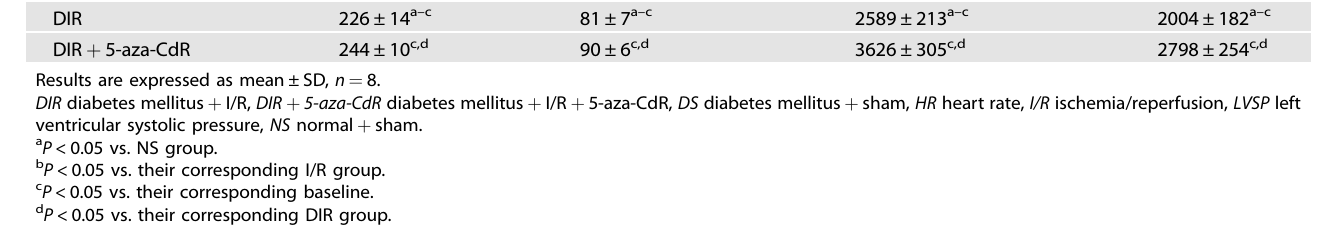
Results are expressed as mean ±SD, n = 8. DIR diabetes mellitus + I/R, DIR + 5-aza-CdR diabetes mellitus + I/R + 5-aza-CdR, DS diabetes mellitus + sham, HR heart rate, I/R ischemia/reperfusion, LVSP left ventricular systolic pressure, NS normal + sham. a P < 0.05 vs. NS